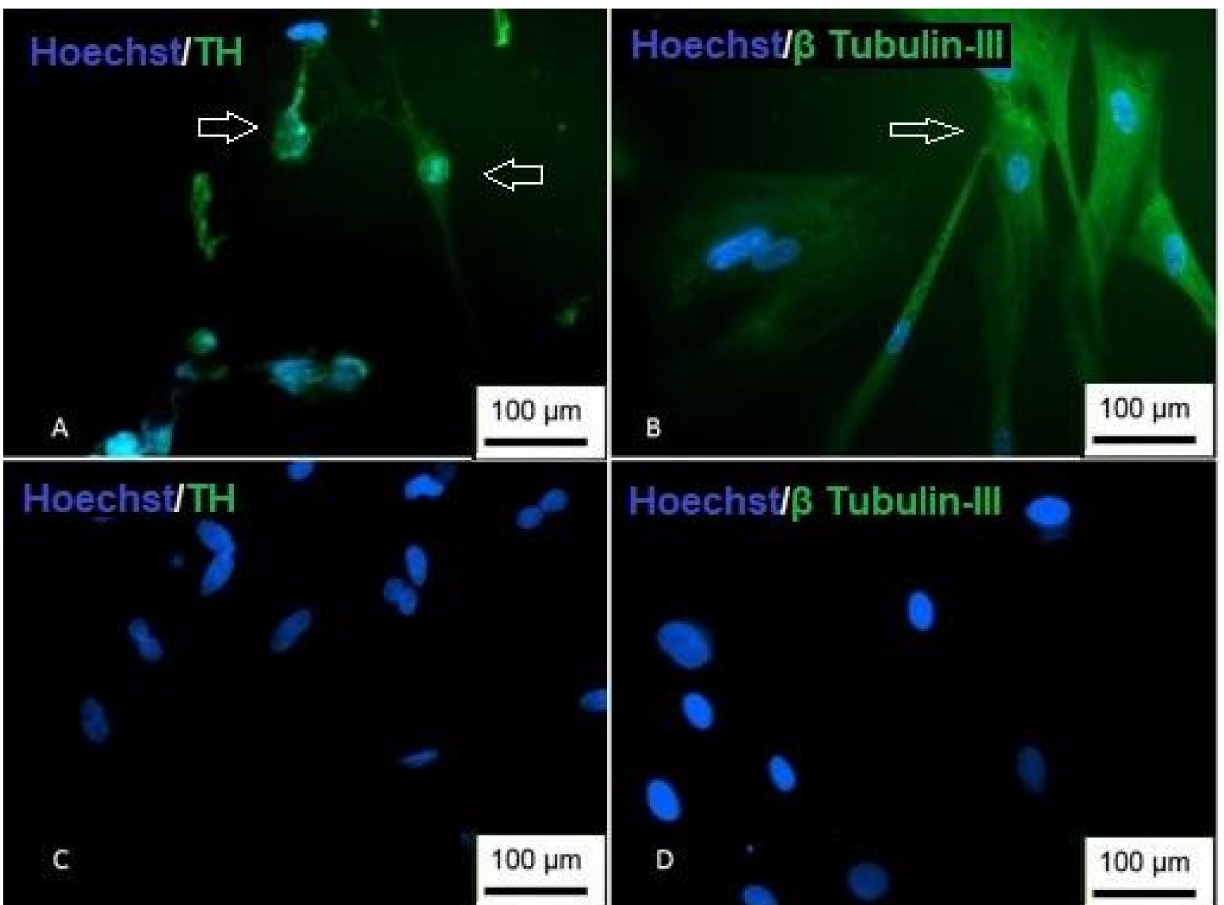
Figure 19. Immunocytochemistry of dopaminergic differentiation. ( A ) Cells are showing nuclear staining (blue) and positive staining for TH (green); ( B ) cells with positive staining for β Tubulin- III; ( C ) undifferentiated TH control; ( D ) undifferentiated β Tubulin-III control (inversion optical microscopy—200 × ). Scale bar, 100 µ